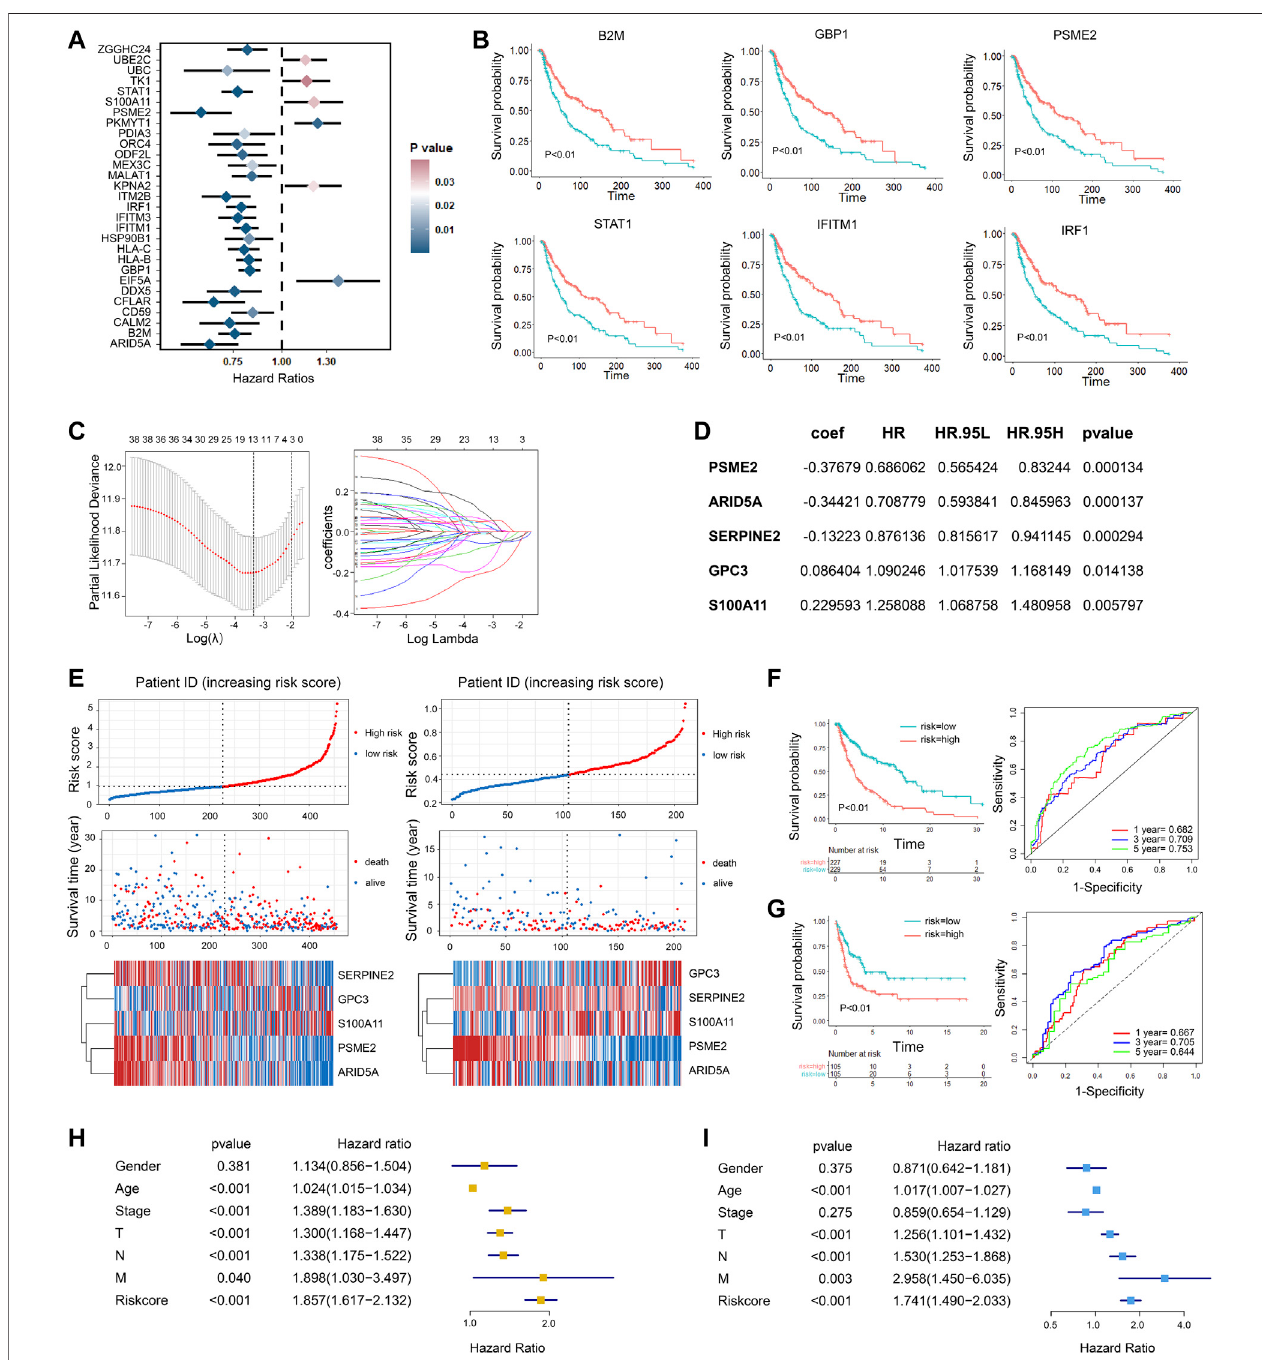
FIGURE 5 | Development of gene signatures for overall survival prediction in melanoma patients. (A) Univariate Cox regression analysis showing the hazard ratios (HRs) with 95% con fi dence intervals (CIs) and p values for metagenes. (B) Kaplan – Meier curves for progression-free survival of the representative genes identi fi ed by univariate Cox regression. (C) Cross-validation for tuning parameter screening in the LASSO regression model. (D) The fi ve genes ’ hazard ratios (HRs) and 95% con fi denceintervals(CIs)andcoef fi cientsscreenedbymultivariateCoxregression. (E) Thedistributionoftheriskscoreandsurvivaloverviewofmelanomapatients in TCGA cohort (left) and validation cohort (right). In each dataset, the risk score distribution, gene expression pro fi les, and patients ’ survival status are displayed. (F,G) . Kaplan – Meier and time-dependent ROC analysis for the risk score in the training cohort (F) and validation cohort (G) . (H,I) Univariate Cox (H) and multivariate Cox (I) regression analyses of clinical parameters and prognostic model for OS.